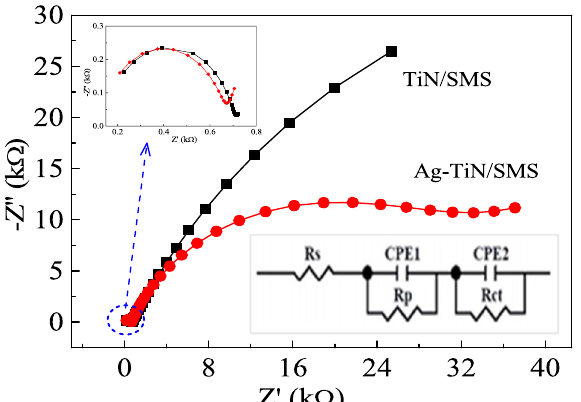
Figure 7. Electrochemical impedance Nyquist plots of Ag-TiN/SMS (red filled circle) and TiN/SMS (black filled square) electrodes 0.02 M PBS (pH7.0), Amplitude of 5 mV from 10 –2 ~ 10 5 Hz with bias voltage of − 0.4 V.